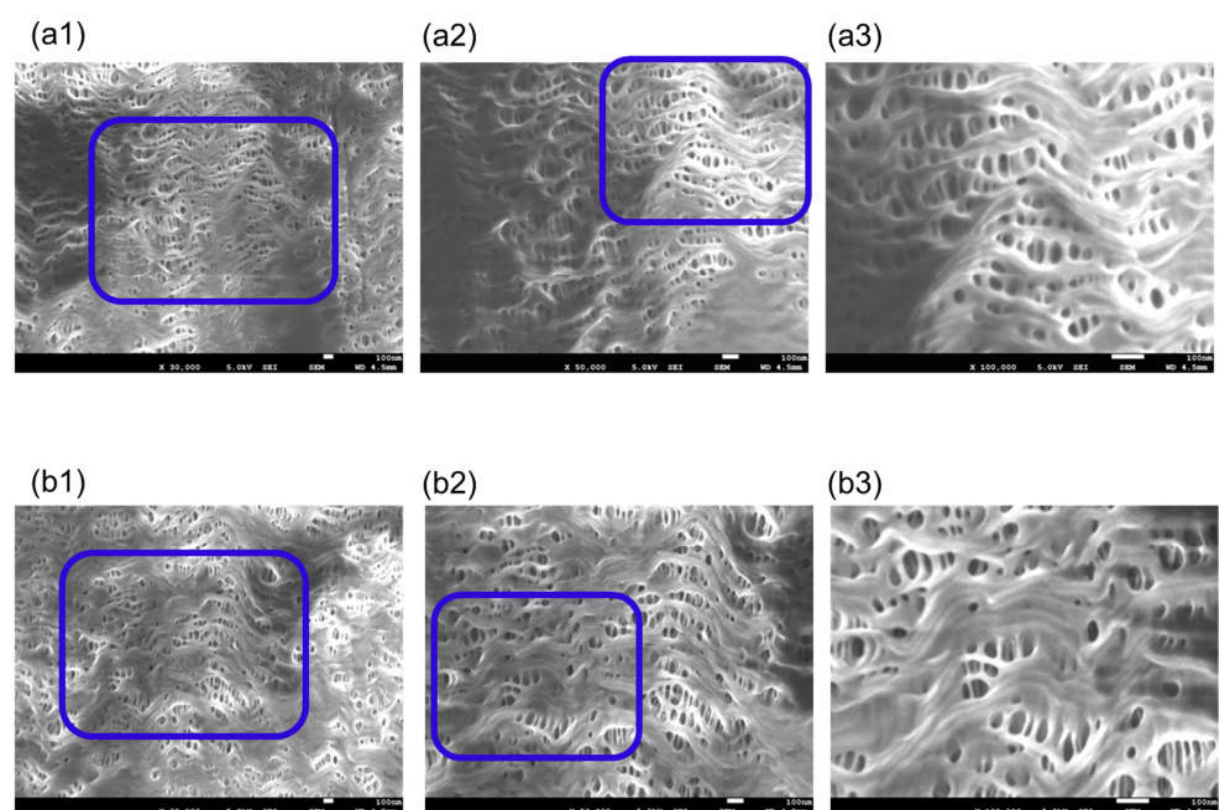
Figure 7. FE-SEM images of BIOCUBE ® (dry), (a) the surface of inner lumen of the capillary membranes and (b) the outer surface of the capillary membranes: (1) ×30,000; (2) × 50,000; and (3) ×100,000, respectively. The image of (3) shows magnified images of the pores enclosed by the blue square in (2), and the image of (2) shows magnified images of the pores enclosed by the blue square in (1).